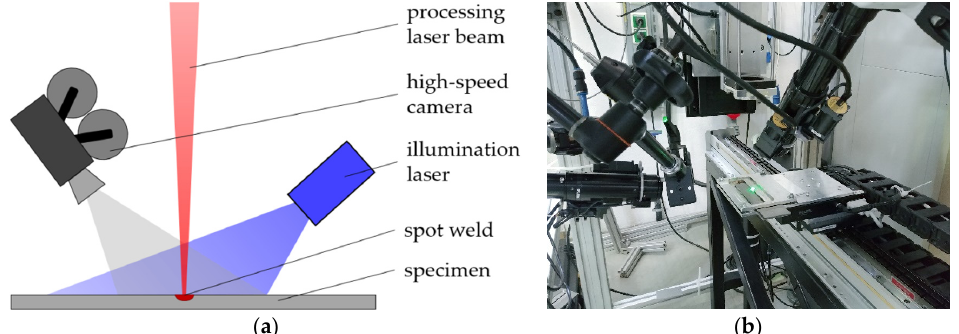
Figure 1. Schematic and photographic views of the used experimental setup: ( a ) schematic front view of the setup. The beam of the processing laser (visualized red) impinges on the specimen from the top. The welding process is monitored using a high-speed camera. To ensure sufficient illumination, an additional, defocused IR illumination laser (visualized blue) at λ = 808 nm is used. ( b ) Photograph of the experimental setup.